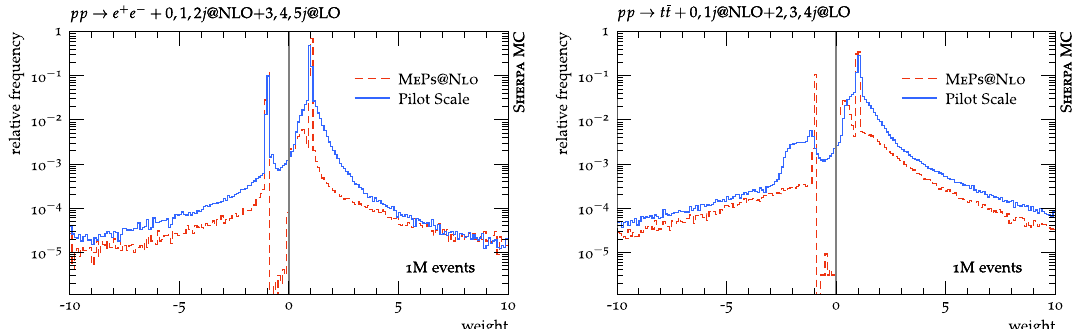
Fig. 5 Weight distribution of events using either the default M E P S @N LO algorithm (red dashed) or the pilot scale strategy (blue solid) described in Sect. 4. Please note, phase space biasing has been disabled for this